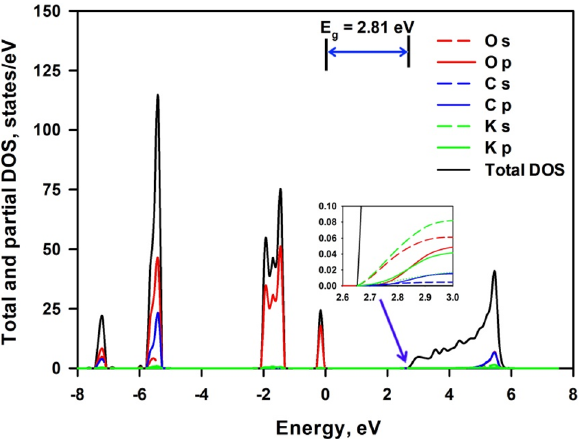
Figure 7. Total and projected density of electronic states of 1-layer K 2 CO 3 . The inset is a magnificence of the CBM region. The energy is given relative to the Fermi energy set at zero.